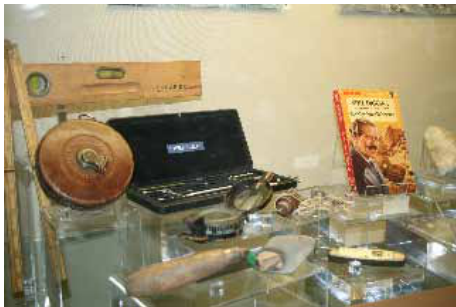
Fig. 2: Part of the Breaking Ground exhibi- tion in the A.G. Leventis Gallery. Pho- to: Andrew Reynolds.